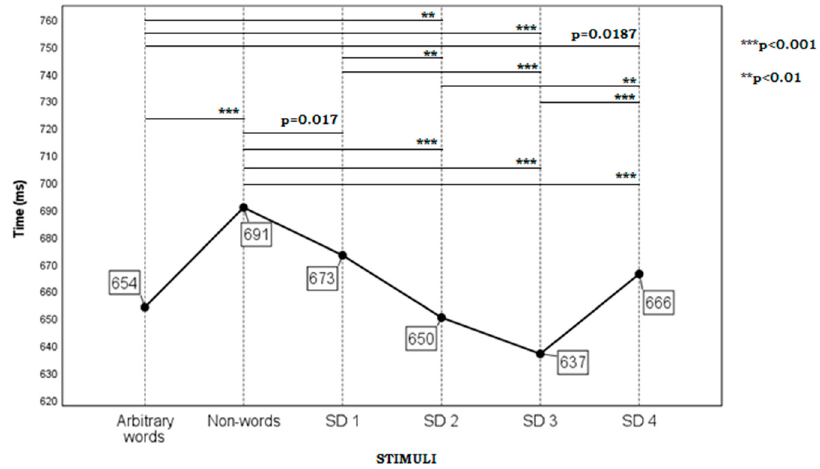
Figure 3. Word recognition time (in ms) depending on the type of the stimuli in Russian.